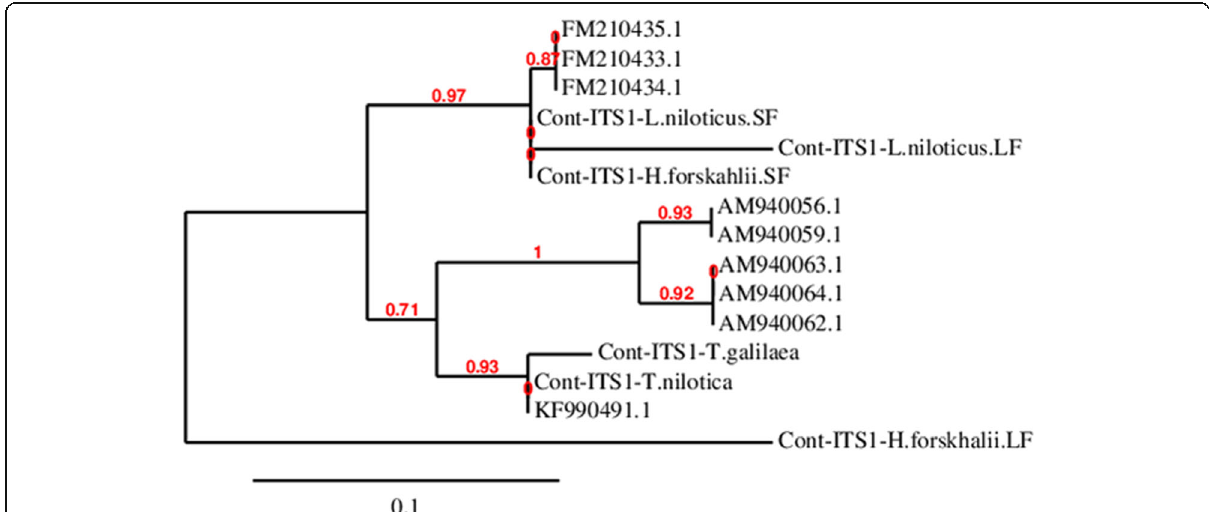
Fig. 7 Phylogenetic tree of the aligned 15 ITS-1 sequences from Contracaecum larvae including 6 ITS-1 sequences, identified in this study, using the Phylogeny.fr program (http://www.phylogeny.fr/). Bootstrap support values are shown on the branches. The compared sequences are represented by accession